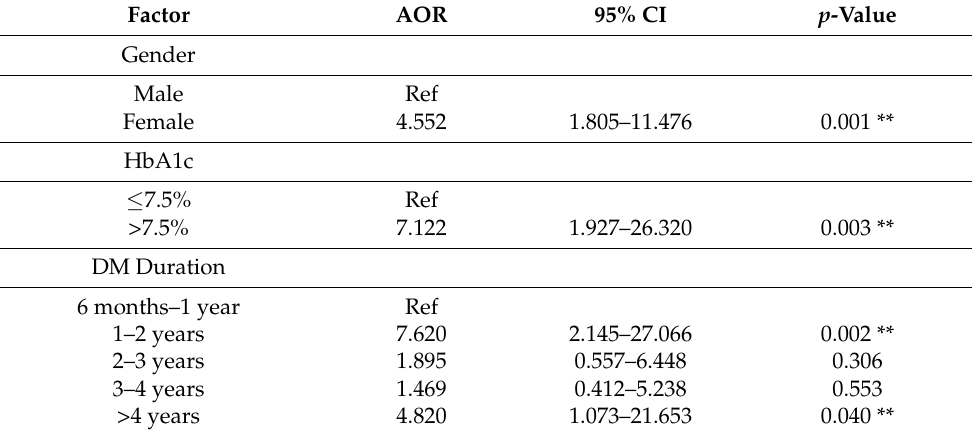
Table 4. Multivariate regression analysis to determine the effect of depression on the selected socio-demographic characteristics of patients ( n =